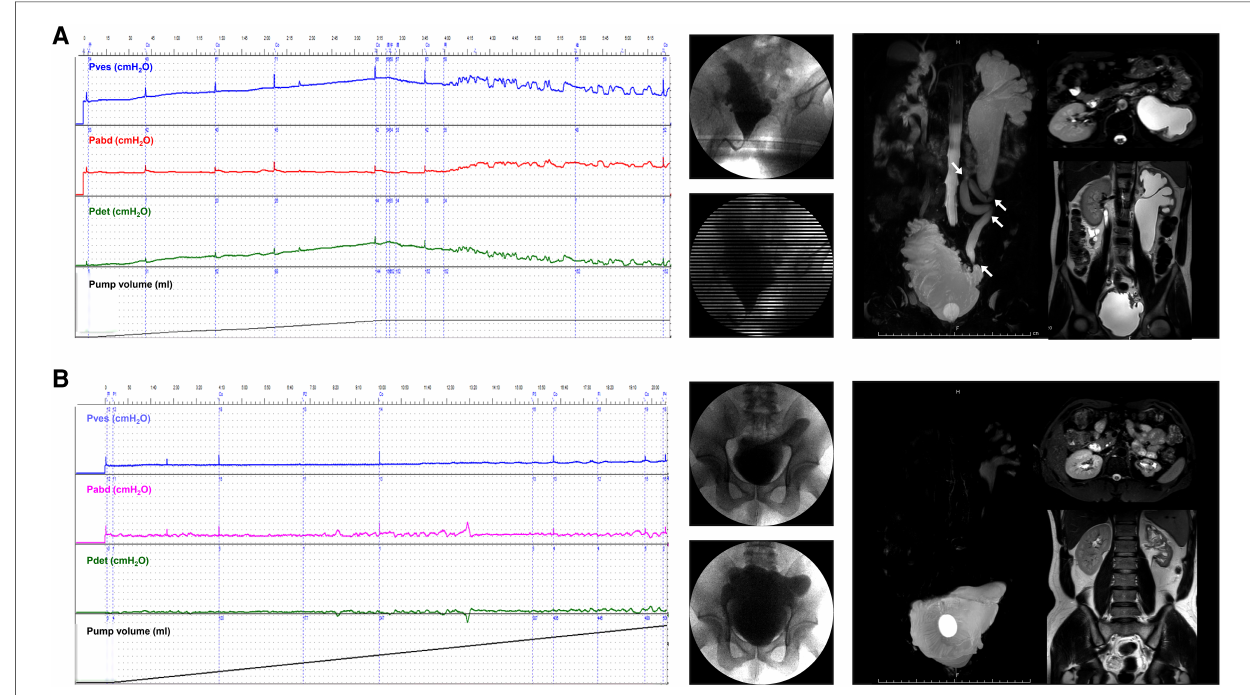
FIGURE 3 Improvement of VUD parameters and UUTD grades in a patient with preoperative oUUTD. ( A ) A 35-year-old man was admitted to our hospital with dysuria since birth. The serum creatinine was 96.2 µmol/L, and isotope renography showed a glomerular fi ltration rate of 13.0 ml/min (left) and 67.0 ml/min (right). VUD showed decreased bladder capacity (151.0 ml) and bladder compliance (5.8 ml/cmH 2 O), with a maximum detrusor pressure of 35.0 cmH 2 O. No VUR was observed; however, incontinence was observed at a volume of 151.0 ml (Pdet: 35.0 cmH 2 O). MRU showed a fully dilated renal pelvis, fl uid- fi lled calices throughout the left kidney, and a tortuous, angulated ureter (Grade 4) with external compression and proximal ureter dilation above the obstruction that could not be relieved using a preoperative indwelling catheter for suf fi cient bladder drainage. The arrows indicate